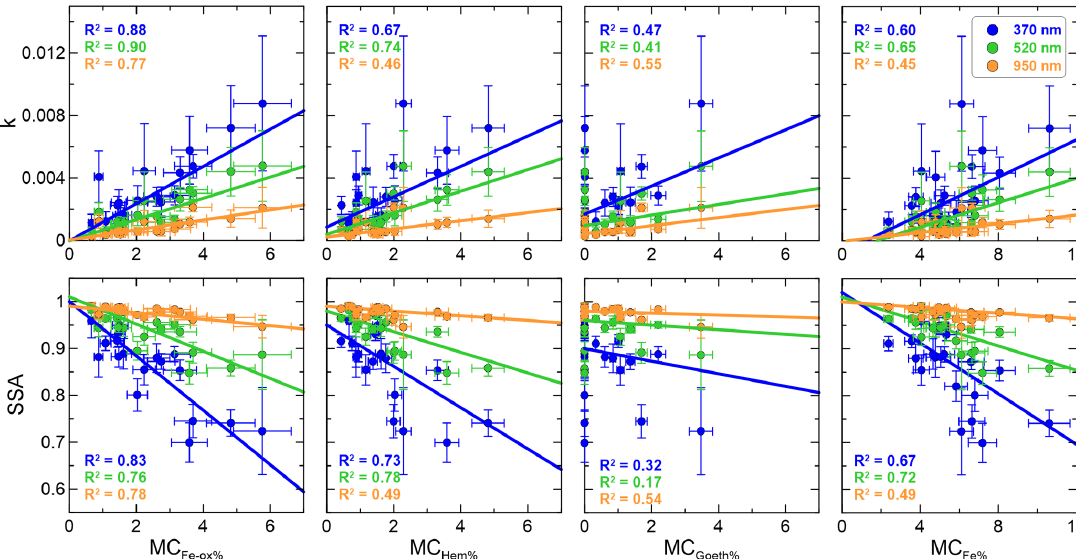
Figure 9. Experiment-averaged imaginary part of the refractive index ( k , top panels) and single-scattering albedo (SSA, bottom panels) at 370, 520, and 950nm versus the mass concentration of iron oxides (MC Fe-ox% ), hematite (MC Hem% ), goethite (MC Goeth% ), and elemental iron (MC Fe% ) measured for the different dust samples analyzed in this study. The calculated linear fit regression lines are shown, together with the correlation coefficients of the fits ( R 2 ). The legend indicates the line styles used in the plots. Data for the Taklimakan sample were excluded from the k and SSA plots versus MC Fe-ox% , MC Hem% , and MC Goeth% due to the absence of iron oxide data for this sample.